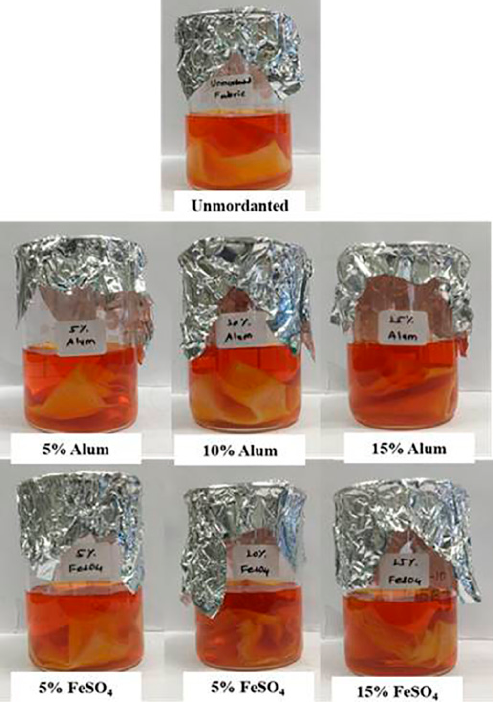
Figure 12. Dyeing of mordanted and un-mordanted cotton fabrics with crude pigment extract of G. triuniae NFCCI 4873.